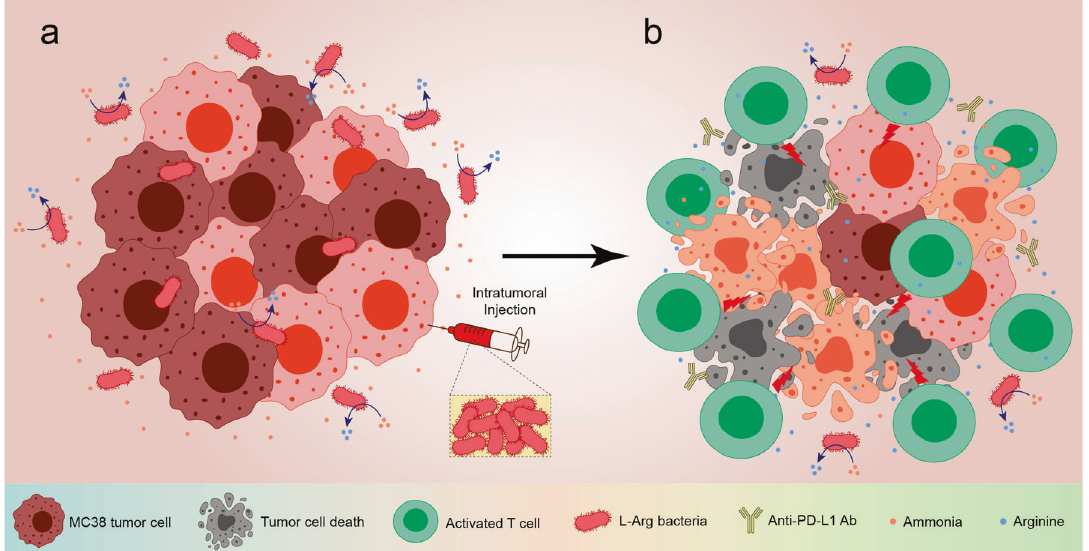
Fig. 1 Intratumoral injection of L-Arg bacteria ( a ) shows synergistic anti-tumor effect with anti-PD-L1 antibodies which is dependent on T cell activation ( b ), causing signi fi cant tumor eradication and prolonged survival of tumor-bearing mice. Created with